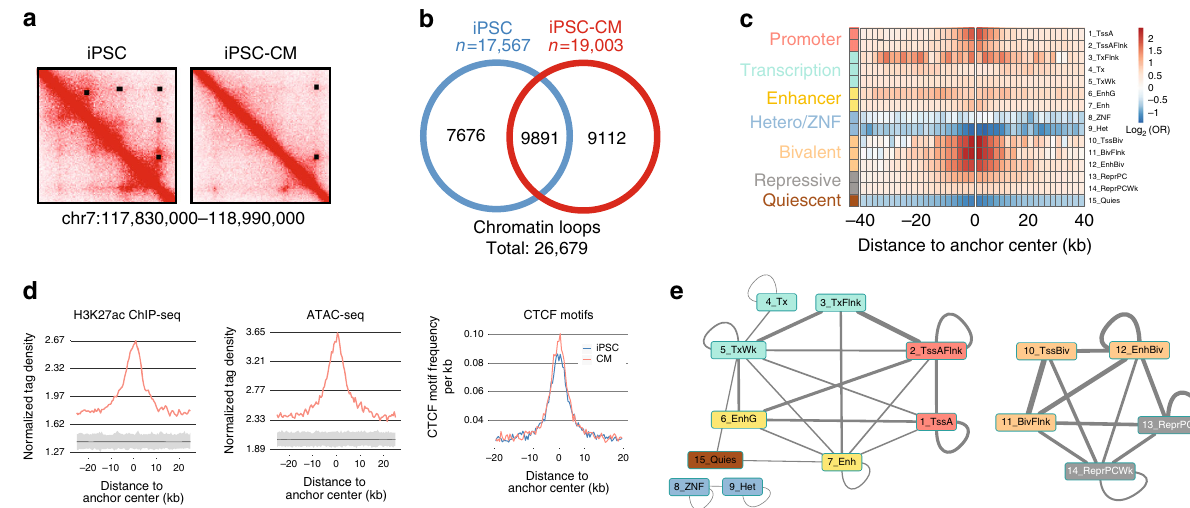
Fig. 2 iPSC and iPSC-CM called loops. a Example contact maps from iPSCs (left) and iPSC-CMs (right) showing differences in looping identi fi ed by callers across cell types, with loop calls shown on the top right half of maps as black rectangles. Two loops appear present and are called in iPSCs, and four loops appear present and are called in iPSC-CMs. b Venn diagram showing the number of chromatin loop calls unique and common to both cell types. c Heatmap showing enrichment of regulatory regions near iPSC-CM called loop anchor centers. The 15 ROADMAP chromatin states of fetal-heart tissue (E083) were used, and the log 2 odds ratio of enrichment is indicated by color (red positive, blue negative) for each 2 kb interval across an 80 kb window. d Density plots showing distribution of epigenetic marks and motifs relative to the center of loop anchors. Normalized tag densities as measured by Homer from H3K27ac ChIP-seq (left) and ATAC-seq (middle) are shown for loops called in iPSC-CM. Gray regions below the peak signals indicate the results from 1000 null loop sets. CTCF motif frequency per kb (right) is shown for loops called in iPSCs (blue) or iPSC-CMs (red). e Network diagram showing two discrete subnetworks of fetal-heart chromatin states at iPSC-CM called loops, with edges connecting statistically signi fi cant pairs of chromatin states found at opposing loop anchors. The thickness of the edge indicates the odds ratio of enrichment, and the presence or absence of an edge indicates statistical signi fi